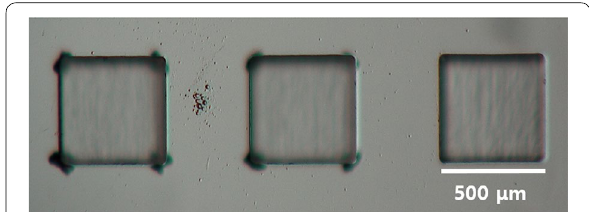
Fig. 3 3D hollow cubes fabricated using different slice spacing. The left one used 10 μm slice and 10 μm hatch spacing. The middle one used 10 μm slice and 20 μm hatch spacing. The right one used 20 μm slice and 20 μm hatch spacing